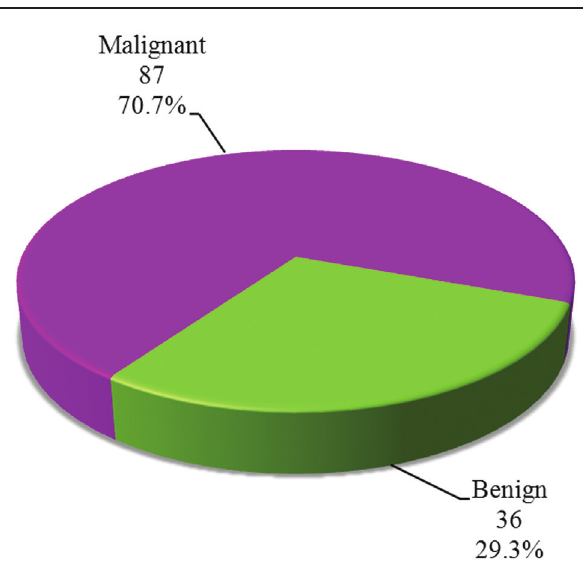
Distribution of the studied cases according to the final diagnosis.